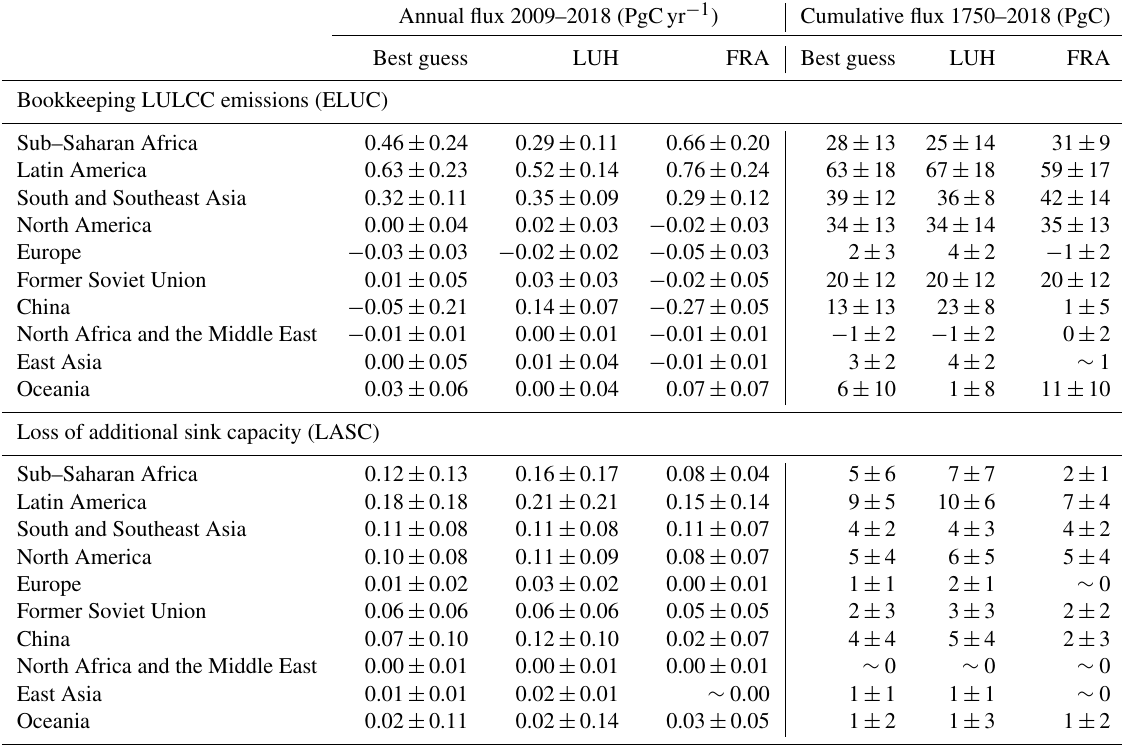
Table 4. Regional breakdown of bookkeeping LULCC emissions and LASC. This is provided for our best-guess estimates and the two main LULCC data sets (LUH2-GCB2019 and FRA2015) separately. The regions are defined in Houghton and Nassikas (2017).